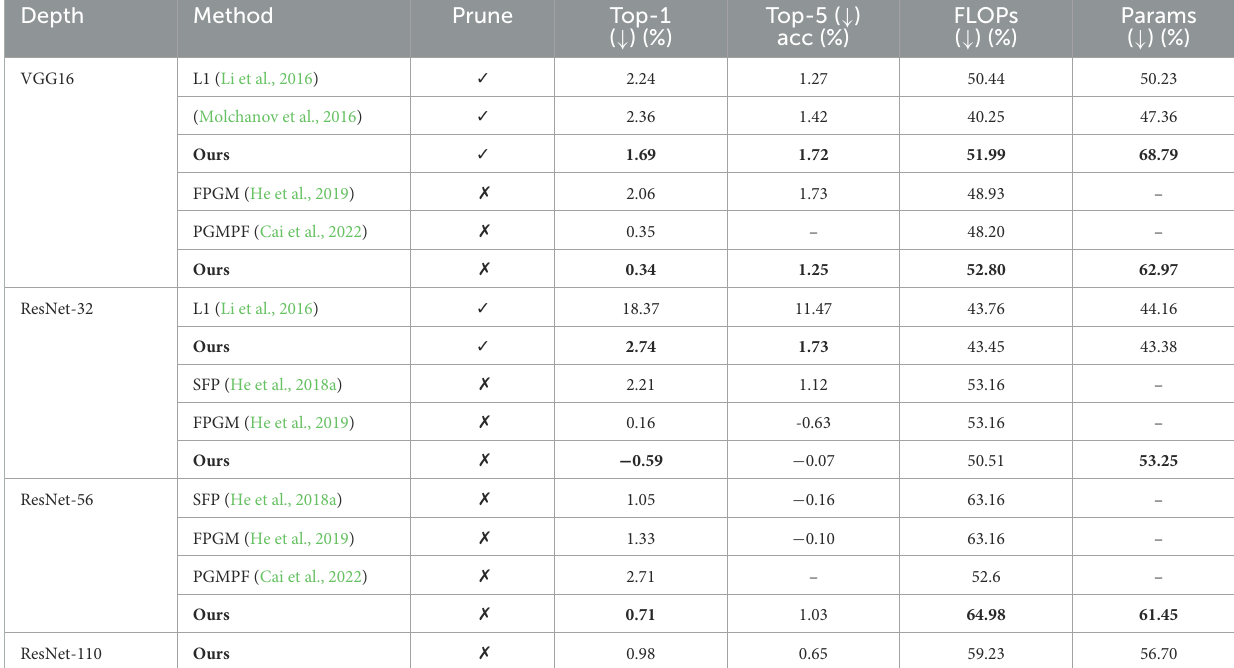
TABLE 3 Comparison of pruned ResNet on CIFAR100.